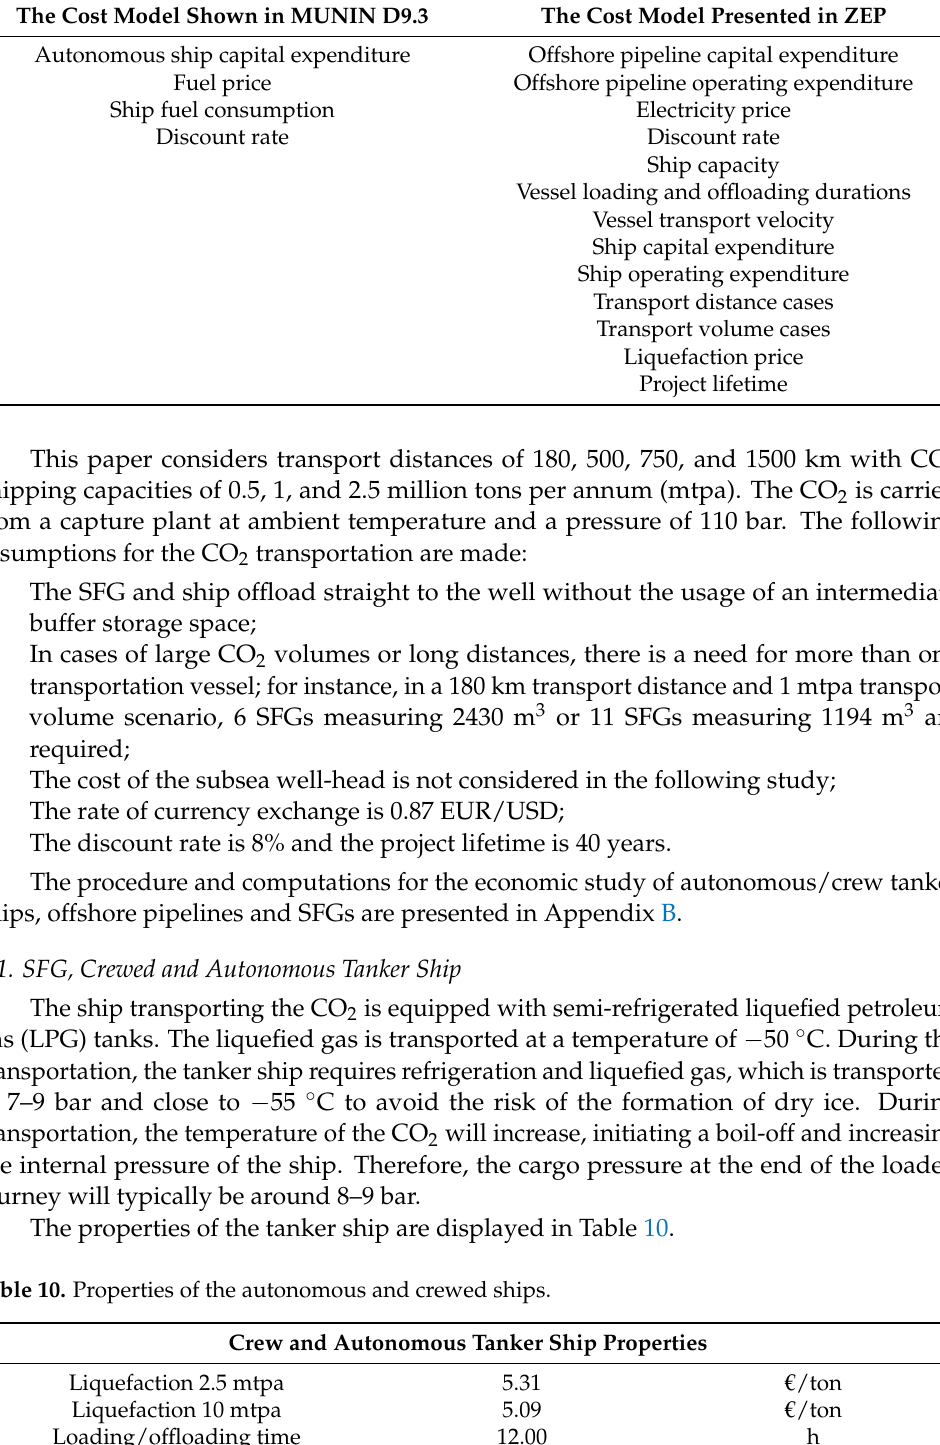
Table 9. Cost models presented in the MUNIN D9.3 and ZEP reports. The Cost Model Shown in MUNIN D9.3